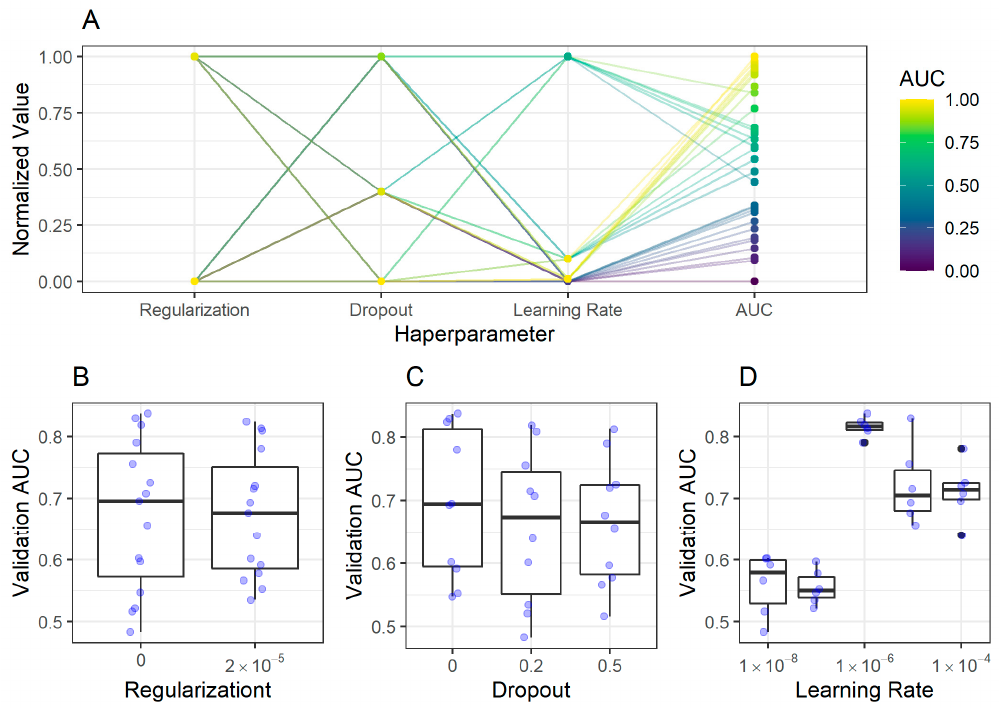
Figure 4. Impact of hyperparameters on the validation AUC in classification of corpus image patches. ( A ) The coordinates plot shows the dependency of hyperparameters and resulting AUC for di ff erent trained models shown as dots. While the ( B ) regularization and ( C ) dropout had almost no consistent impact on the validation AUC of corpus image patches, the ( D ) learning rate had an impact, displaying the highest AUC at 1 × 10 − 6 .